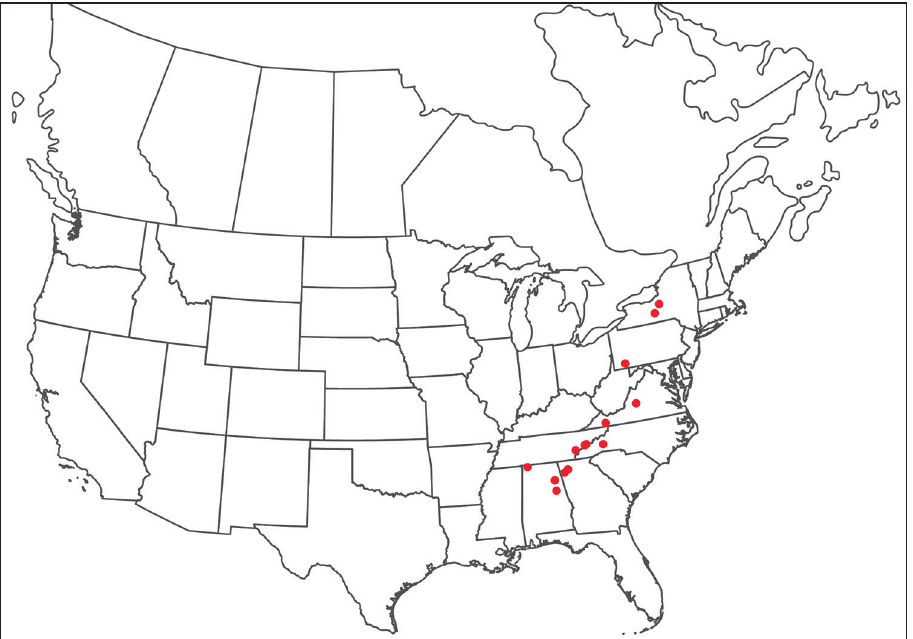
Figure 199. Torrenticola projector